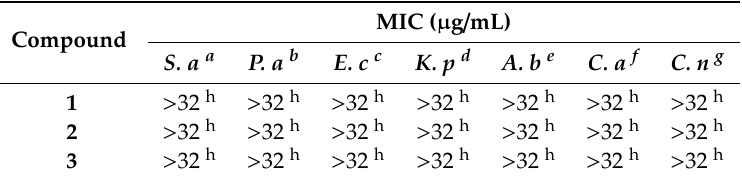
Table 4. Antimicrobial activity of compounds 1 – 3 .